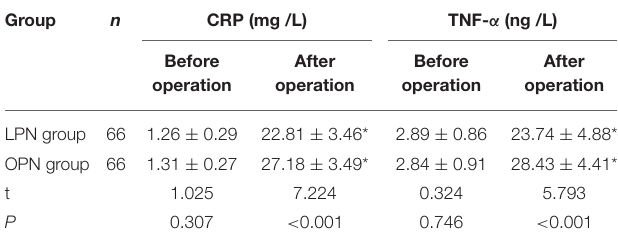
TABLE 4 | Comparison of CRP and TNF- α levels ( x ± s).